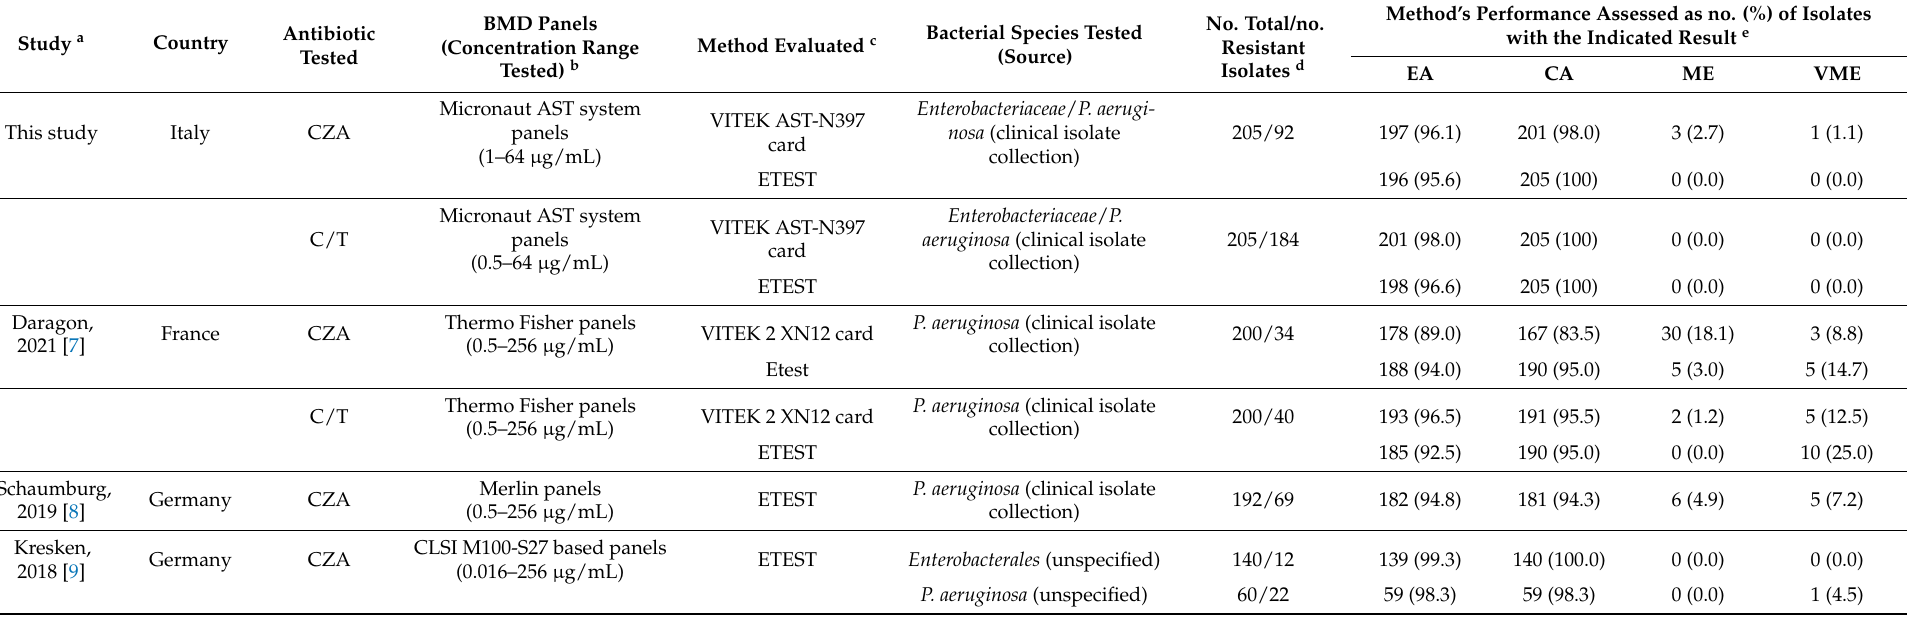
Table 3. Studies conducted in Europe to evaluate the VITEK 2 and/or ETEST methods for determining the susceptibility of Gram-negative bacterial species to the CZA and C/T combination